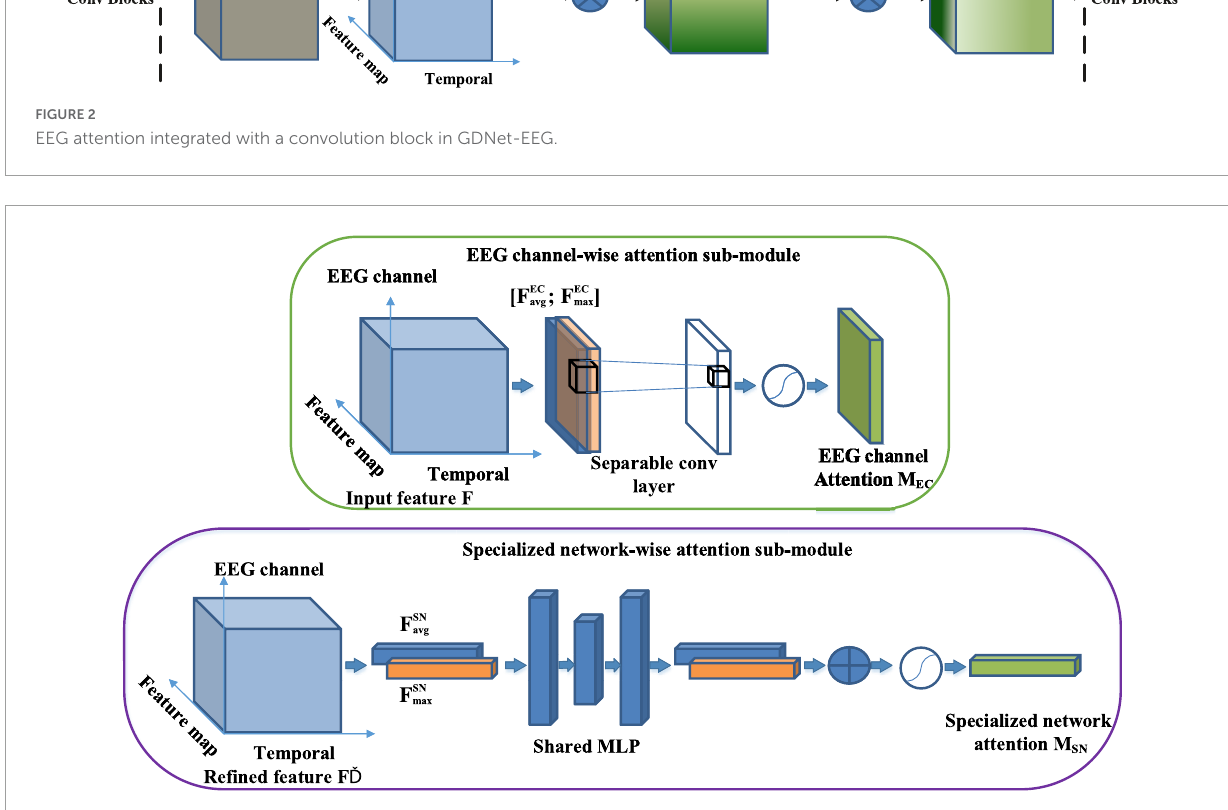
FIGURE3 The overall process of the EEG attention module. The module includes two sequential parts: EEG channel-wise attention sub-module and specialized network-wise attention sub-module.